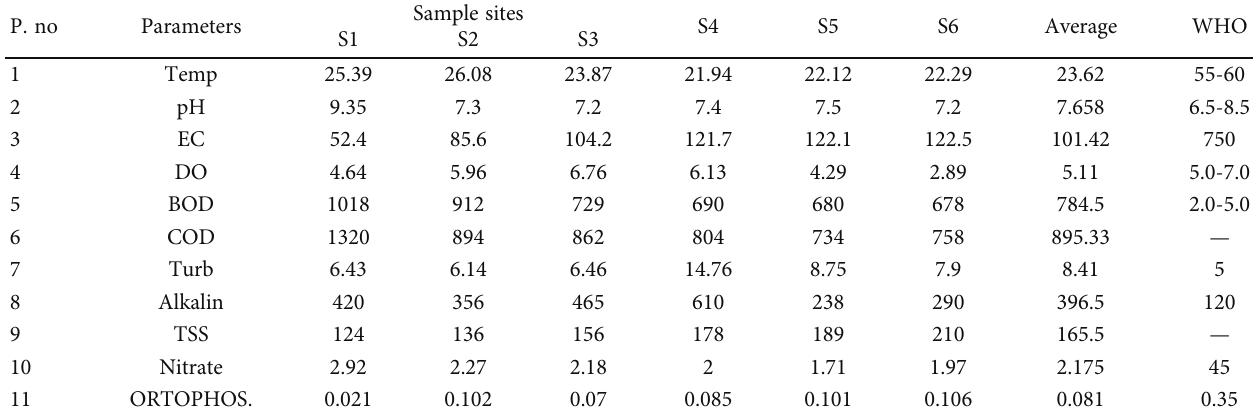
Table 1: Physicochemical parameters of Awetu river water recorded on each sample site. P.